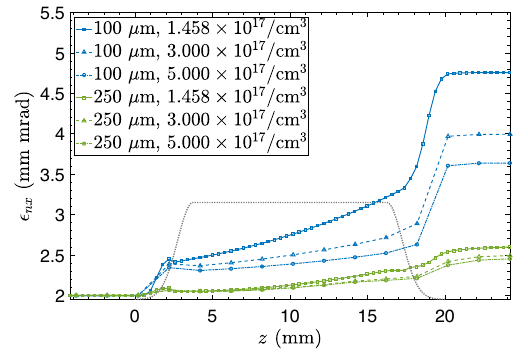
FIG. 12. Evolution of emittance along the APL with several different peak APL plasma densities. The grey-dashed line represents the APL plasma distribution in arbitrary units. The initial electron beam sizes used for this simulation were 100 and 250 μ